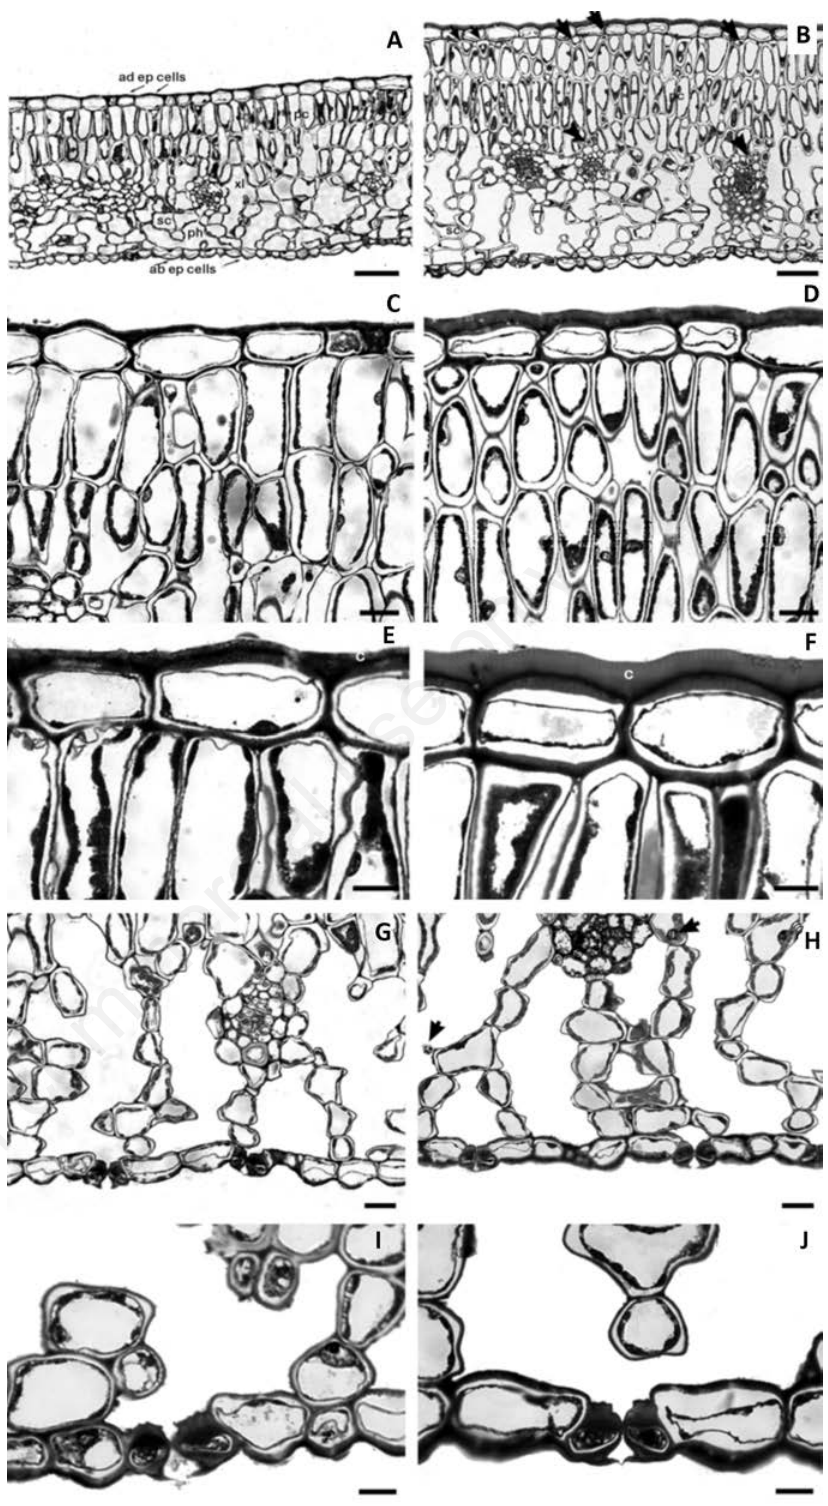
Figure 2. Micrograph of cross-section of Berberis microphylla leaves collected on Moreno (A,C,E) and Ushuaia sites (B, D, F). A-B, view of total cross-section leaf with adaxial epi- dermal cells (ad ep cells), abaxial epidermal cells (ab ep cells), palisade mesophyll cells (pc), spongy mesophyll cells (sc), phloem cells (ph), xylem cells (xl) and sclerenchyma cells (arrowhead); C-D, Detail of adaxial epidermal and palisade mesophyll tissues; E-F, Detail of abaxial epidermal cells and cuticle (c). Bars: A-B, 100 µm; C-D, 25 µm; E-F, 10 µm. G-J) Detail of the palisade mesophyll tissue and the stomata of abaxial epidermal of Berberis microphylla leaves collected on Moreno (G,I) and Ushuaia sites (H,J). Bars: G-I, 25 µm; H-J, 10